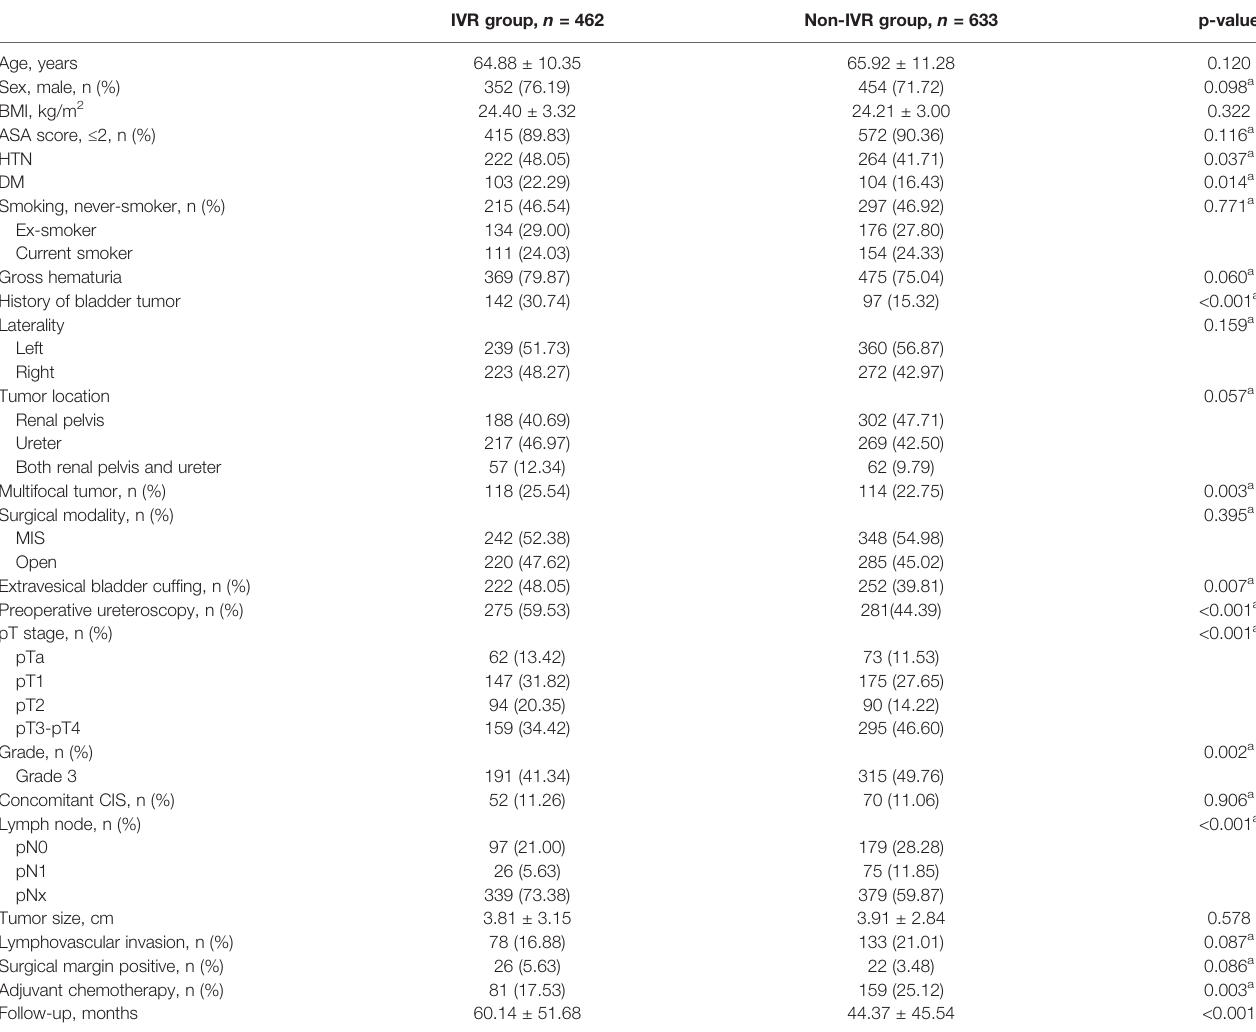
TABLE 1 | Baseline characteristics and operative and pathological